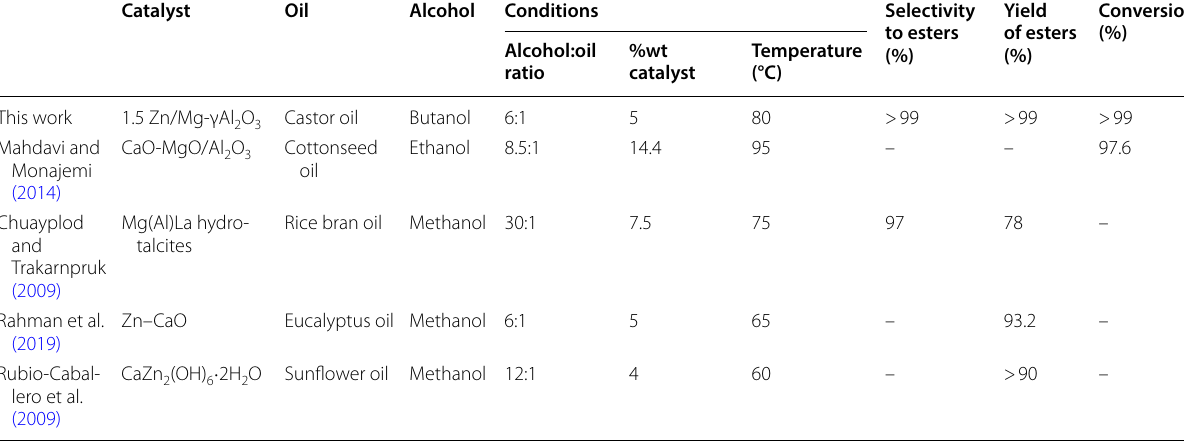
Table 3 Comparison of results between different catalytic systems